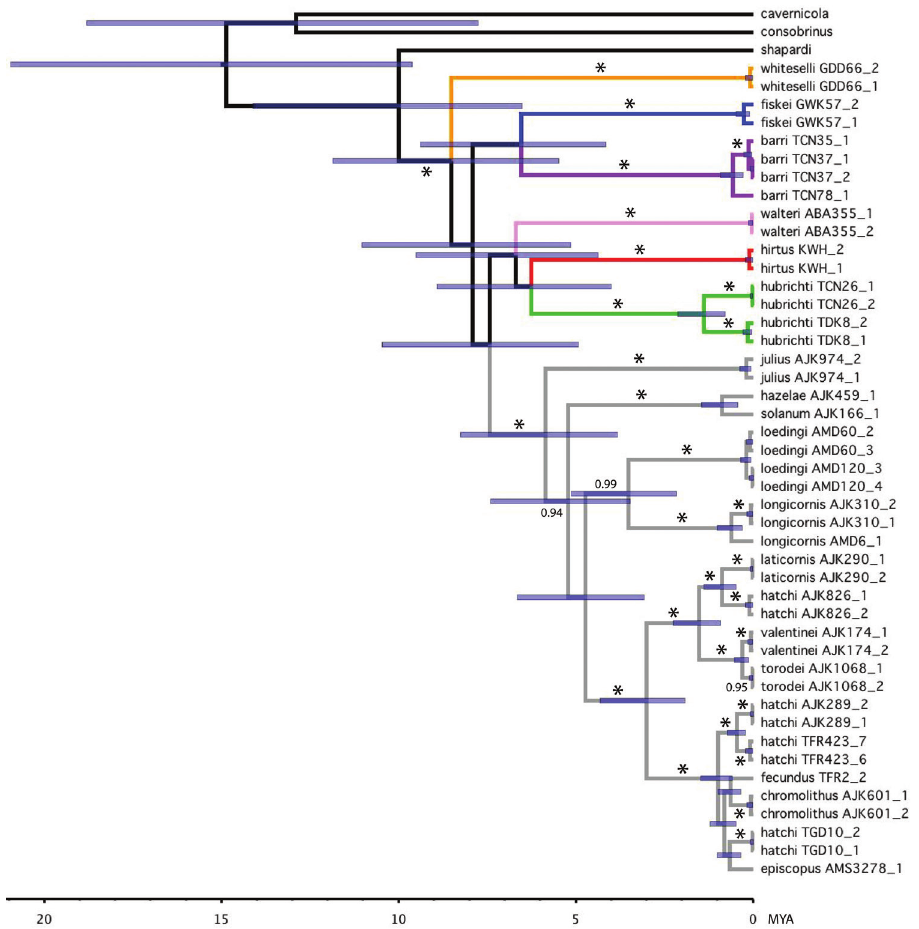
Figure 3. Ultrametric tree for the hirtus -group. Bayesian tree estimated from combined partial mito- chondrial sequence data. Branches supported by posterior probability >0.90 are labeled with values or, for branches with posterior probability of 1.0, an asterisk. Blue bars indicate 95% confidence intervals of estimated ages for the nodes. Taxa are labeled with species name and specimen identifier (Table 1). Scale at bottom indicates divergence times in millions of years as estimated by BEAST (Drummond et al. 2012). Branch colors correspond to those in Figure